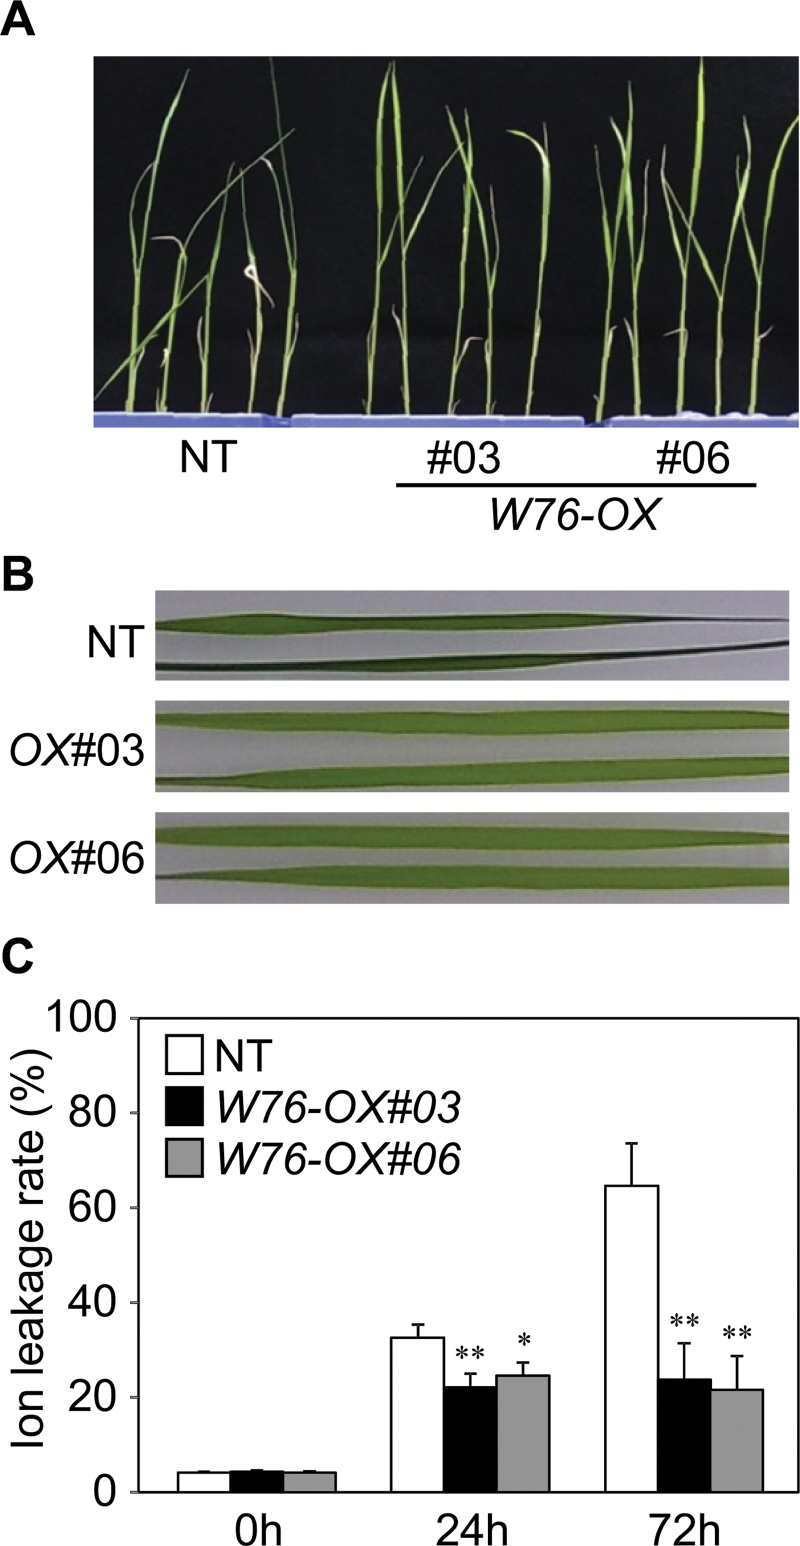
Tolerance of transgenic plants overexpressing OsWRKY76 to cold stress. (A) Plants after treatment with cold stress. Fourteen-day-old plants were incubated at 4 °C in the dark for 72h. (B) Leaf blades after the cold treatment for 72h. (C) Ion leakage rate in the leaf blades after cold treatment. Values are represented as mean values ±SE for eight plants. Significantly lower values compared with the non-transformed control are denoted by asterisks (*P < 0.1, **P < 0.05 by Dunnett’s test). Experiments were carried out three times, and a representative result is shown.